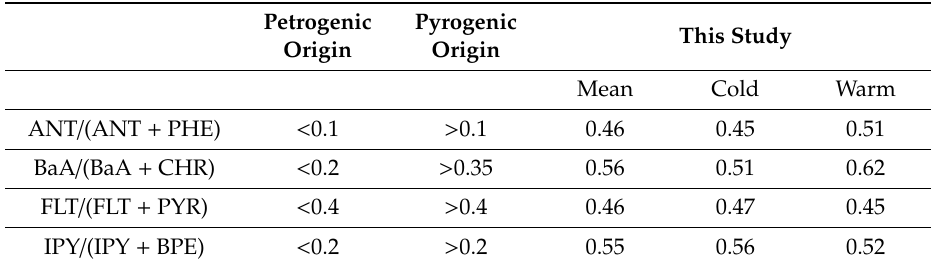
Table 6. MDRs (molecular diagnostic ratios) for the whole sampling campaign and their interpretation from literature